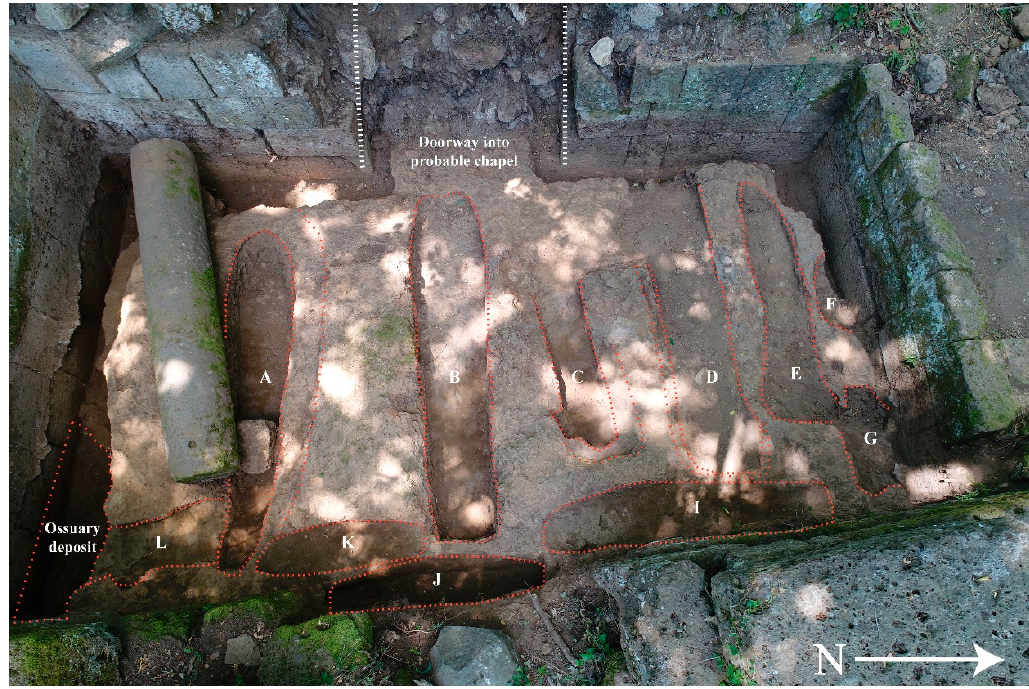
Figure 4. The mortuary structure at San Giuliano. The letters indicate tombs cut into the bedrock. An adult female interred with a fetus or perinatal infant was found in Tomb B. The twin fetuses were found in Tomb F (photo by E. Varley, overlay by C. Zori).